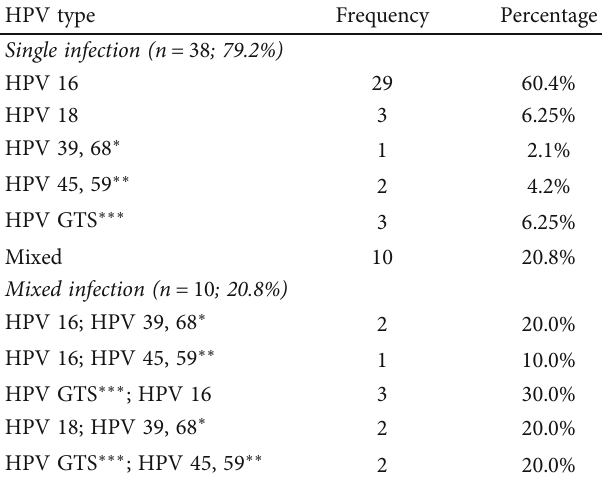
Table 2: Distribution of HPV genotypes among HPV-positive patients ( n = 48